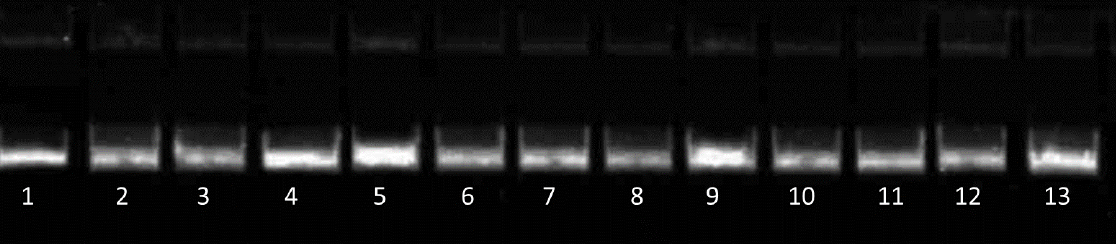
Figure 2. The influence of tested compounds on S. aureus DNA gyrase activity. Decreasing amounts of 1 , 2 , or 3 were incubated with supercoiled pBR322 plasmid DNA (500 ng) and run-on agarose gel. Lane 1: S. aureus DNA gyrase assay with DMSO (control). Lane: 2–5: compound 3 at concentrations 64, 32, 8, 2 μ g/mL, respectively. Lane: 6–9: compound 2 at concentrations 64, 32, 8, 2 μ g/mL, respec- tively. Lane: 10–13: compound 1 at concentrations 64, 32, 8, 2 μ g/mL, respectively.